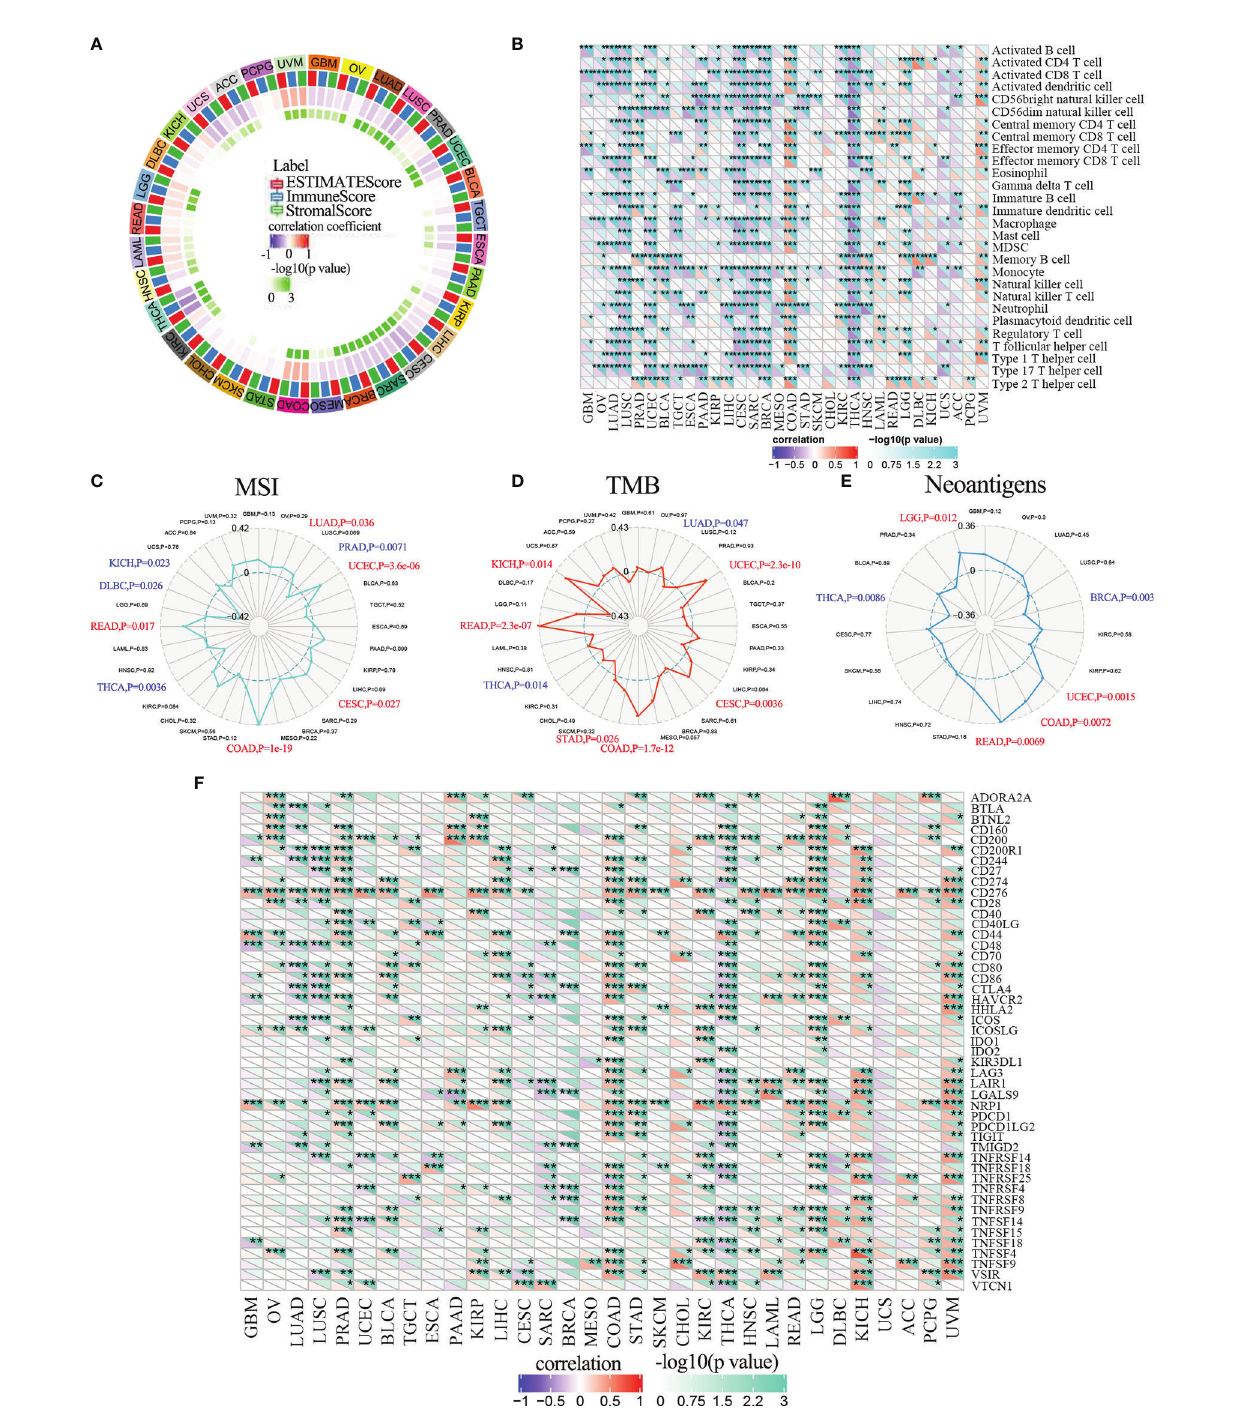
FIGURE 6 | ALKBH5 mRNA expression and immune in fi ltration. (A) The correlations between ESTIMATE scores (ESTIMATE Score, Immune Score, and Stromal Score) and ALKBH5 expression were analyzed in various tumors by Sangerbox portal. (B) The relationship between ALKBH5 expression and immune cell in fi ltration level was analyzed in various tumors by Sangerbox online website. The relationship between ALKBH5 mRNA expression and MSI (C) , TMB (D) , neoantigen (E) and ICP-gene (F) in multiple cancers. Red label indicated positive correlation with ALKBH5 expression and blue label indicated negative correlation with ALKBH5 expression. * P <0.05, ** P <0.01, *** P <0.001, **** P